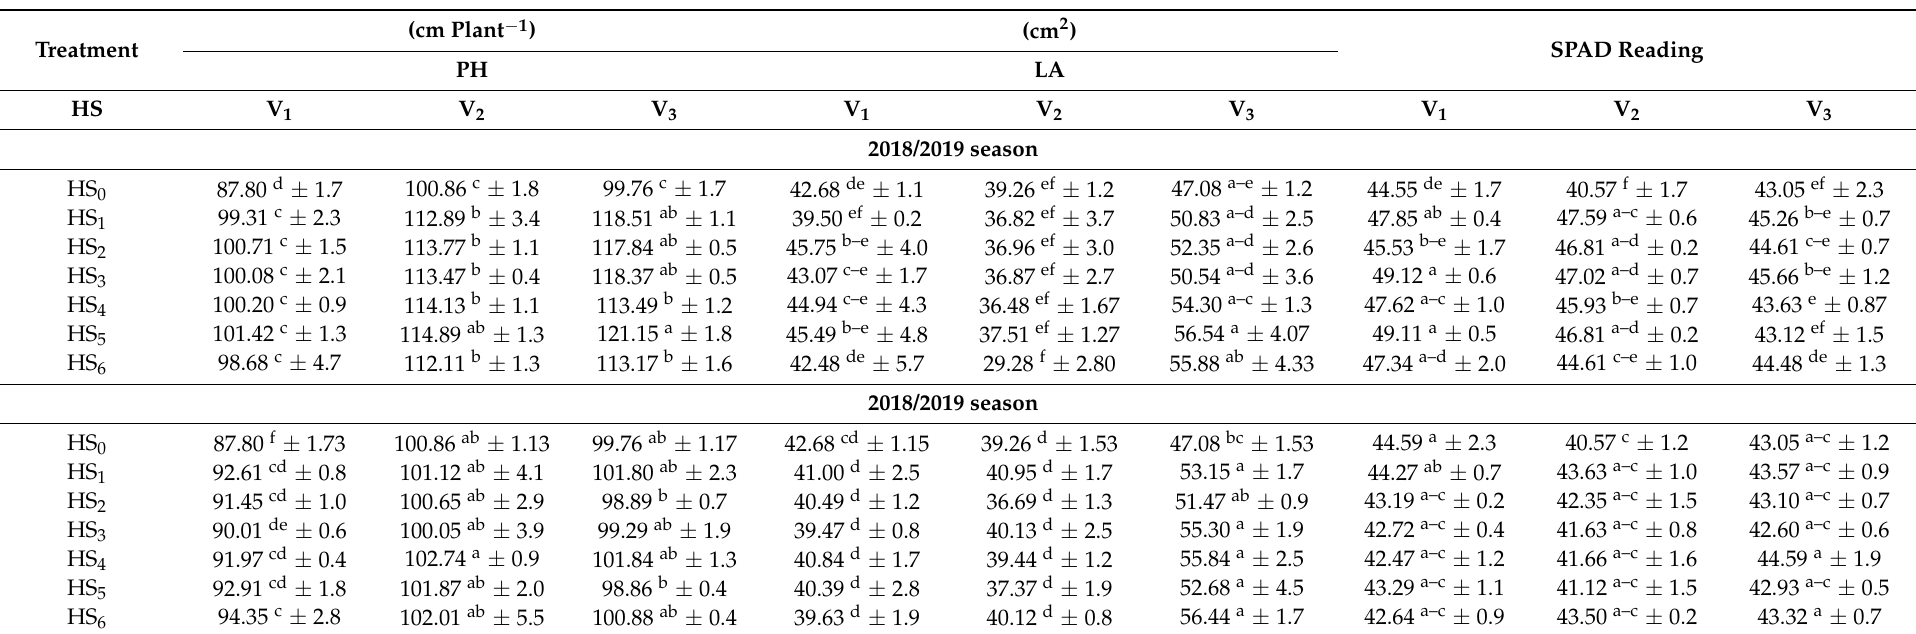
Table 5. Influence of interaction between humic substances and varieties on plant height, leaf area and SPAD reading of wheat plants grown in clay loam soil